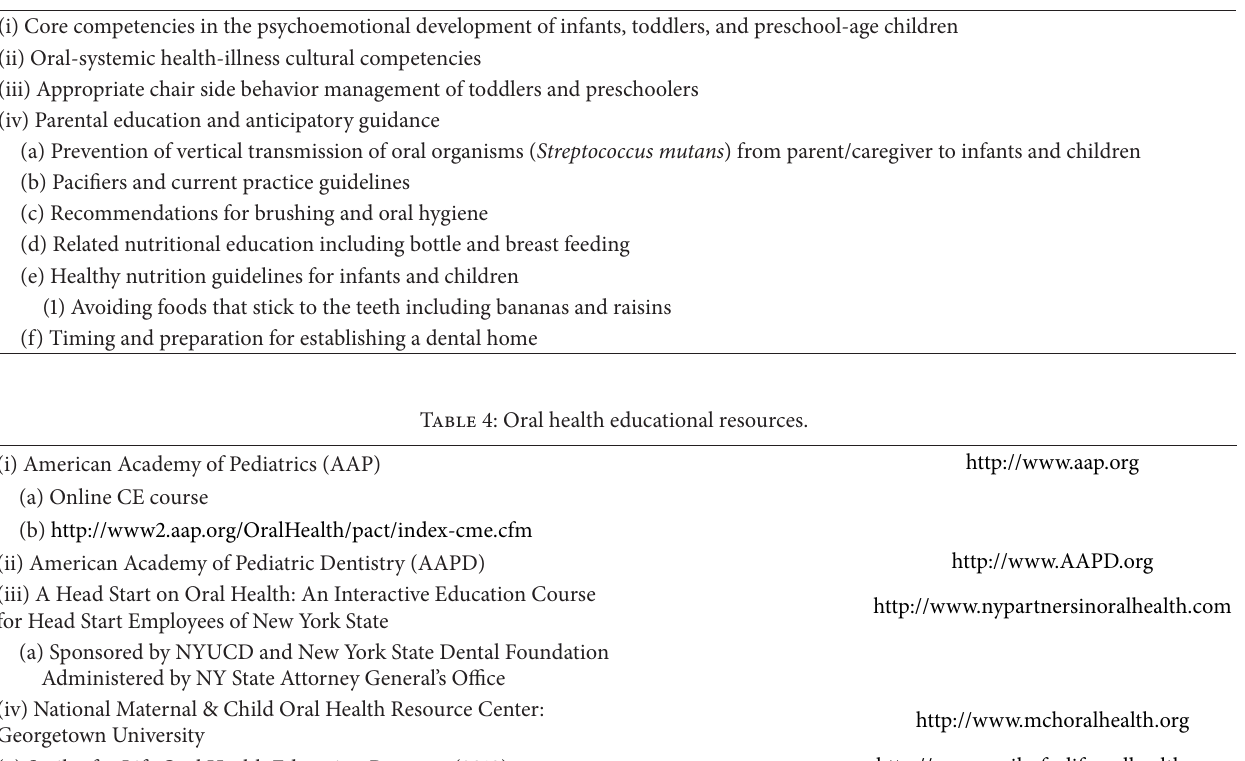
Table 3: Interprofessional affective oral health core competencies.